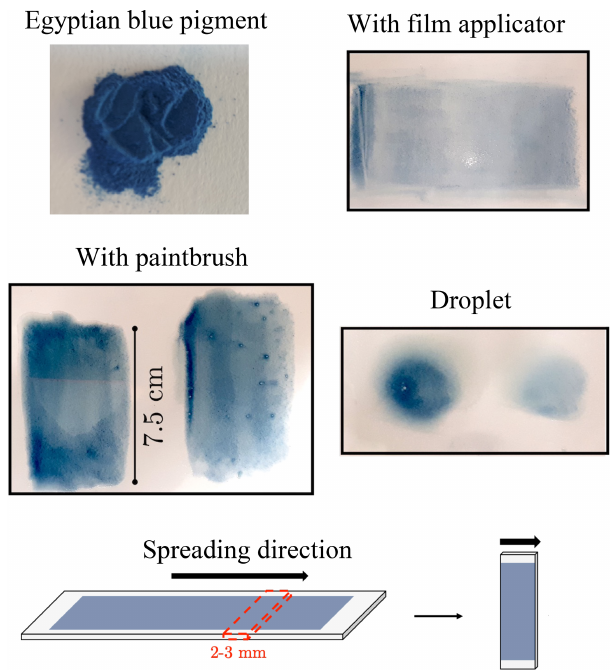
Figure 1. Photographs of the